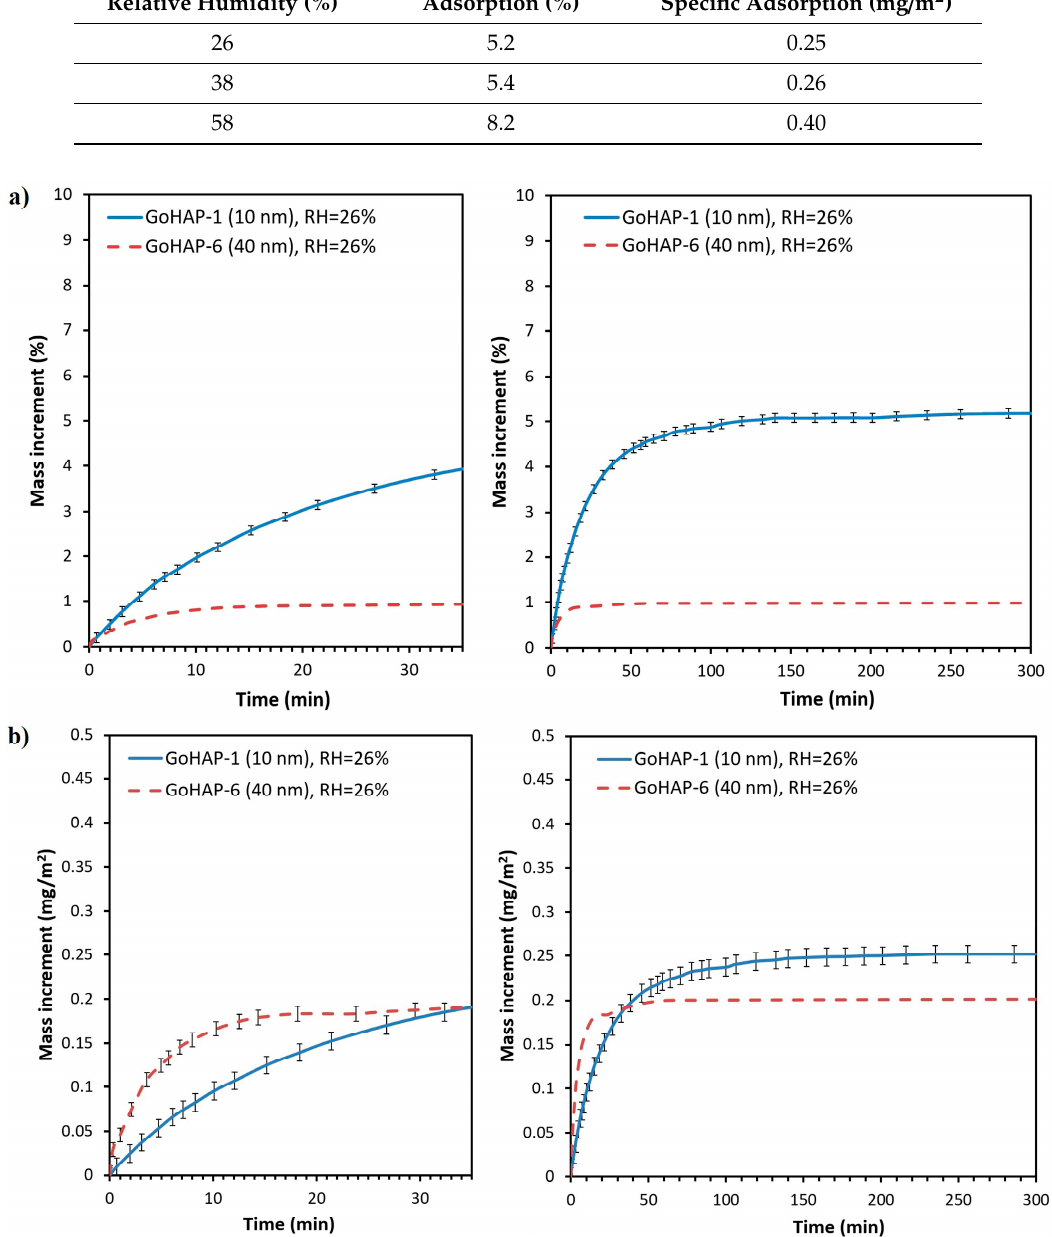
Figure 5. Kinetic curves of water adsorption on GoHAP-1 (10 nm) and GoHAP-6 (40 nm) with an ambient relative humidity of 26%: ( a ) percentage mass change, ( b ) mass increment per 1 m 2 of GoHAP™.